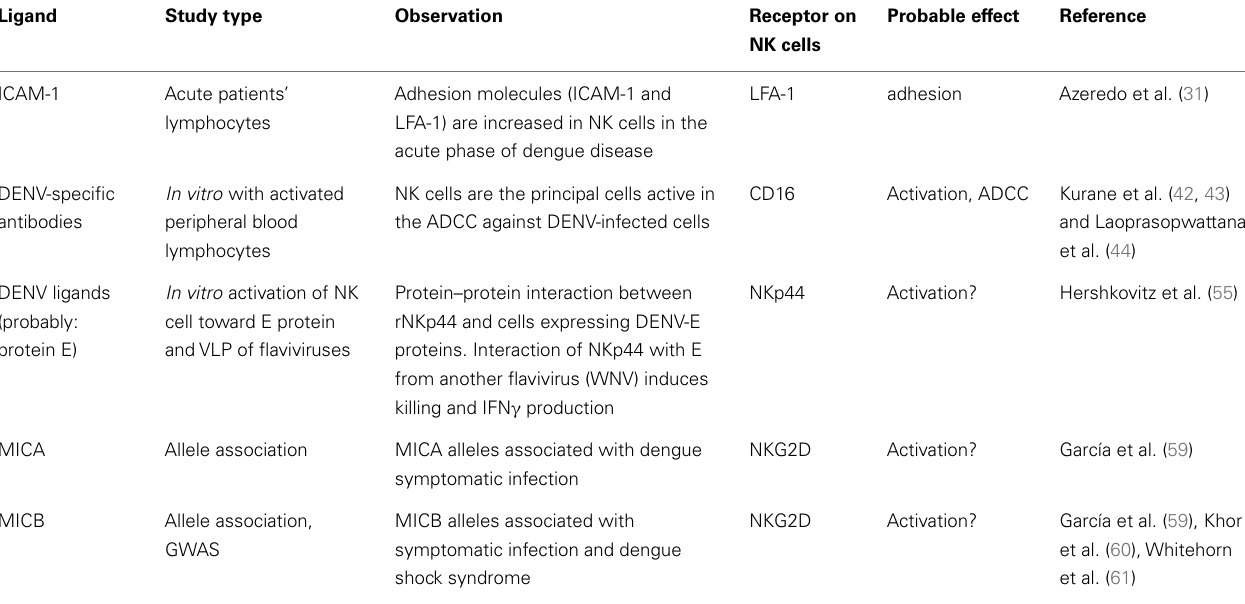
Table 1 | Summary of the published findings related to ligands for receptors on NK cells and dengue virus infection